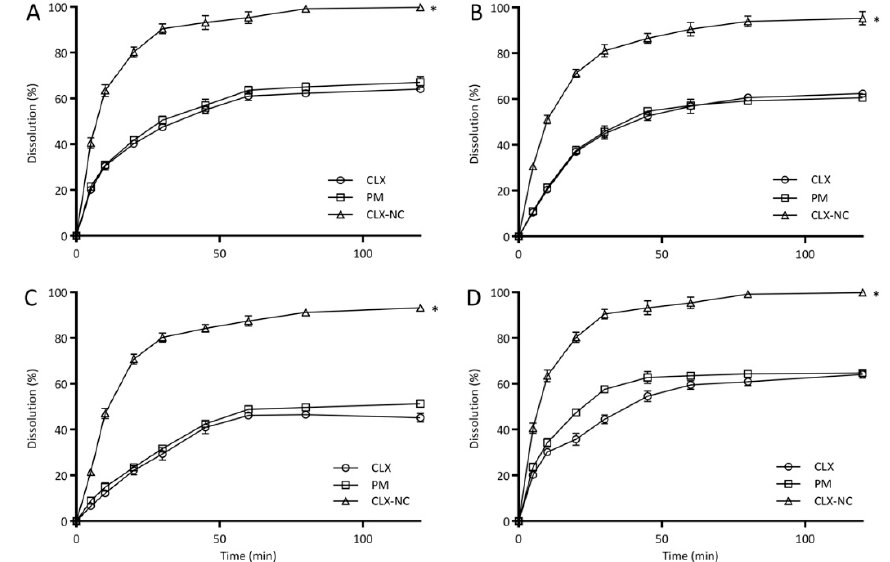
Figure 8. In vitro dissolutionprofiles of CLX crude powder, PM and optimized CLX-NC in different dissolution media ( A : pH 1.2, B : pH 4.5, C : pH 6.8 and D : distilled water) (mean ± standard deviation (SD), n = 3). * implies significant at p ≤ 0.05 compared to CLX crude powder.